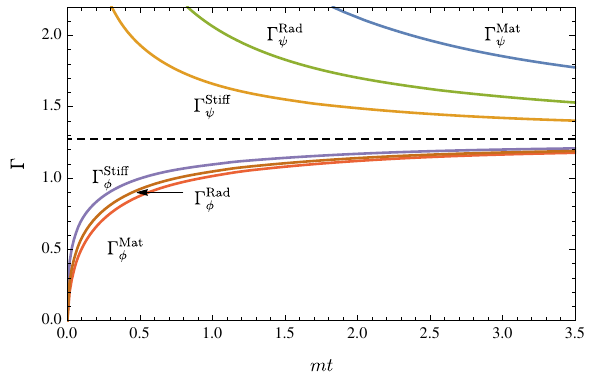
Fig. 2 Exact mean decay rate (cid:8) φ for the scalar channel in units of h 2 m / 64and (cid:8) ψ forthefermionchannelinunitsof λ 2 / 64 m asafunction of mt for radiation, matter and stiff matter dominated universes. The dashed line corresponds to asymptote at 4 /π for all decay